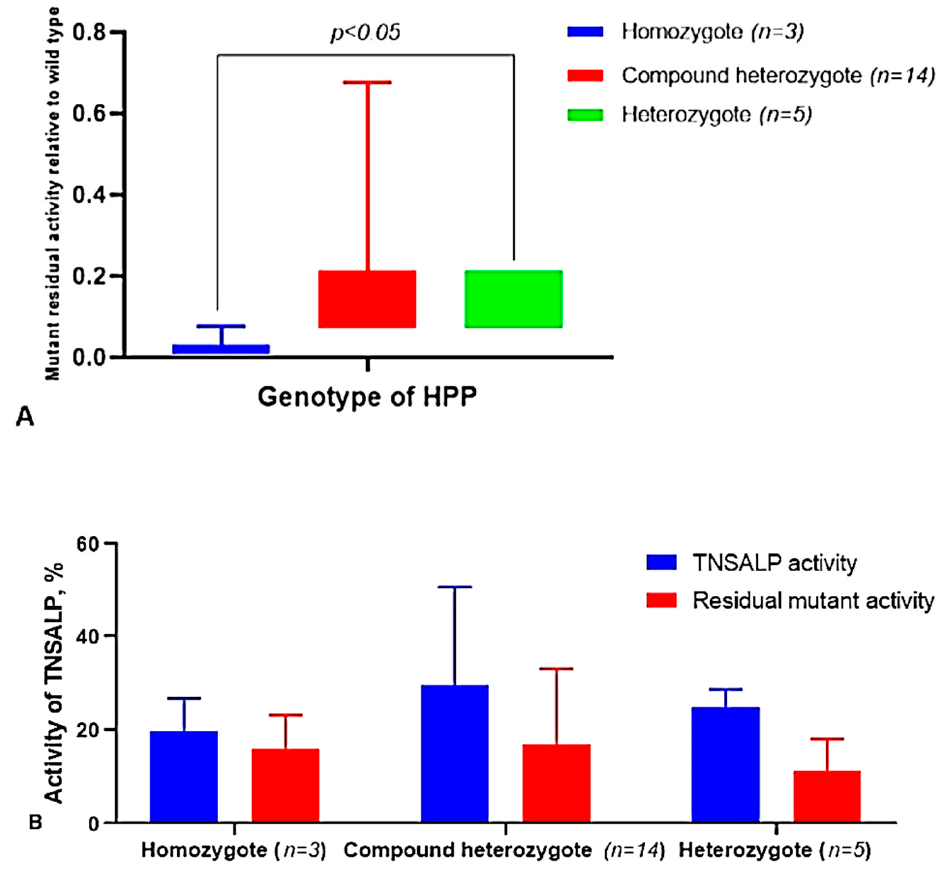
Figure 12. The residual mutant activity of the different variants of the ALPL gene in relation to wild-type activity deepened according to genotype. ( A ) Comparison of the real TNSALP activity in the serum with the theoretically calculated values, depending on the genotypes of the patients with HPP (( B ), see the Material and Methods section).